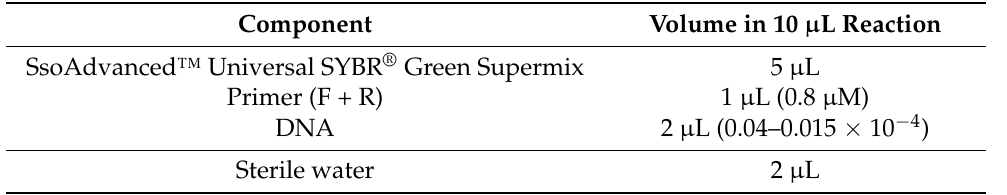
Table 1. Mix Ratio to